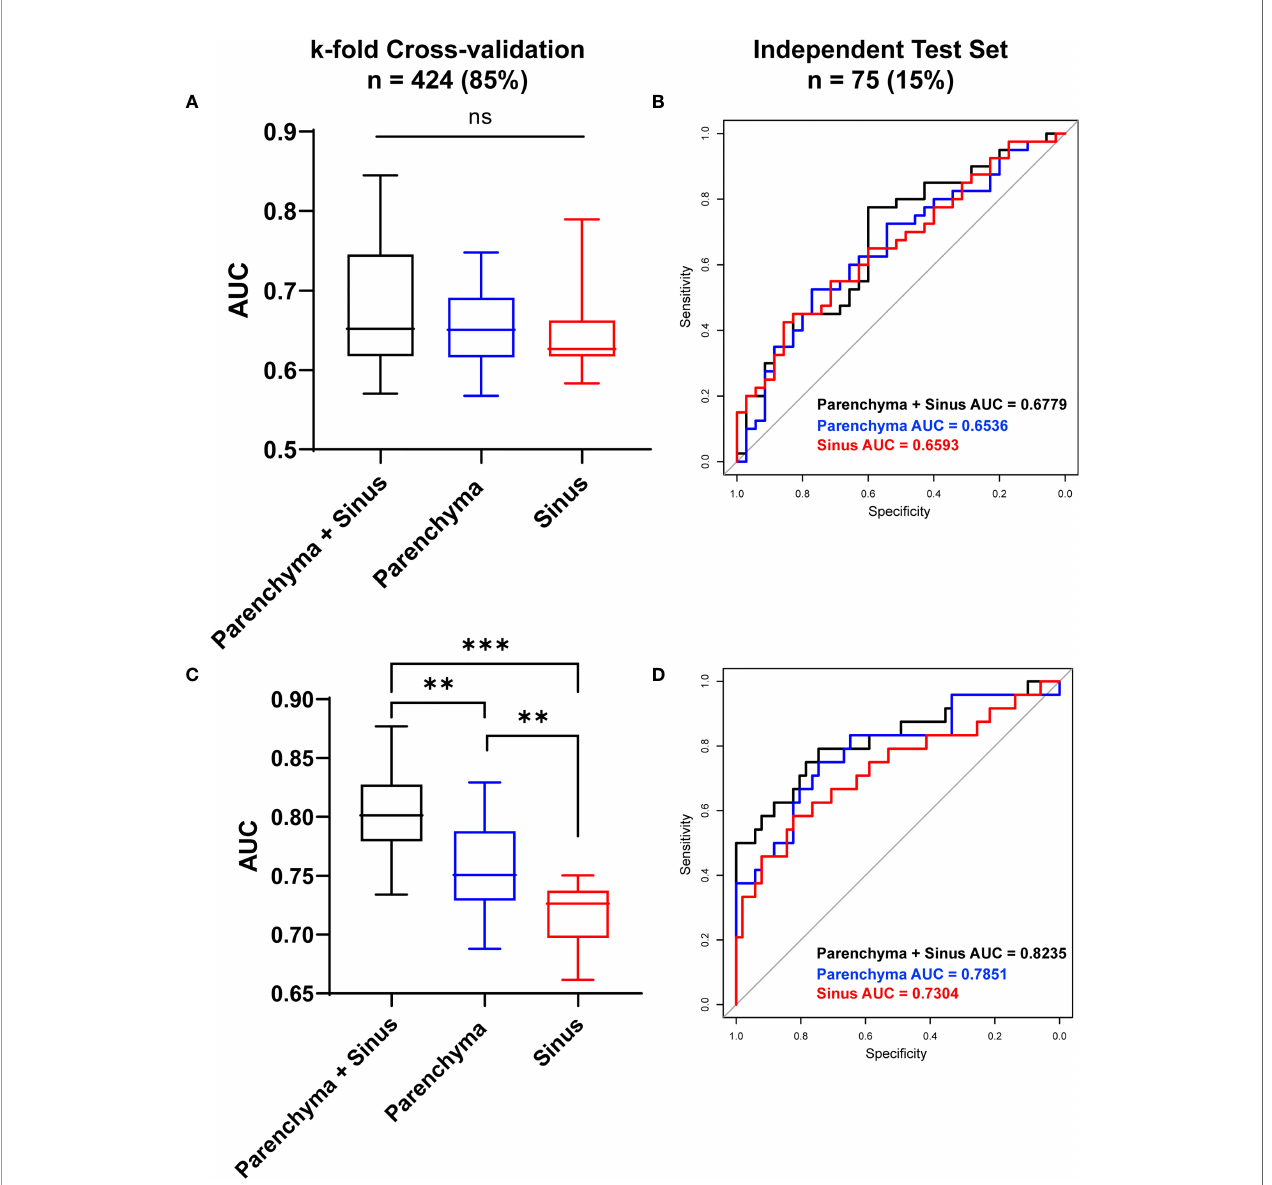
FIGURE 5 | Diagnostic Performance of ultrasound-based radiomics to stratify DKD patients. The diagnostic performance to differentiate DKD and T2DM patient in cross-validation datasets (A) and in independent test set (B) . The diagnostic performance to differentiate high ( ≥ stage III) and low ( ≤ stage II) DKD stages in Cross- validation datasets (C) and in independent test set (D) . AUC, Area under curve; *P < 0.05, **P < 0.01, ***P < 0.001; ns, no signi fi